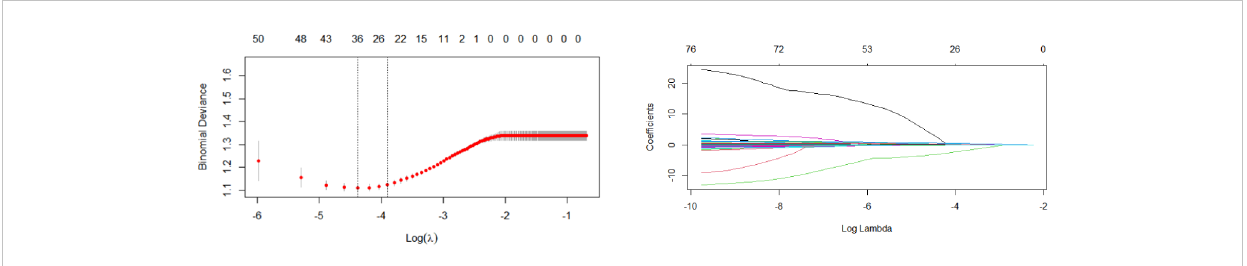
FIGURE 2 Lasso regression for variable selection.